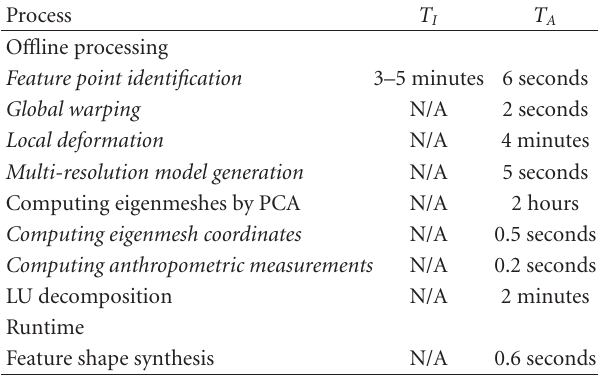
Table 5: Time consumed for di ff erent processes of system implementation. For some processes (in italic), the time spent per example is shown. Notation: time consumed in interactive operation ( T I ), time consumed in automatic computation ( T A